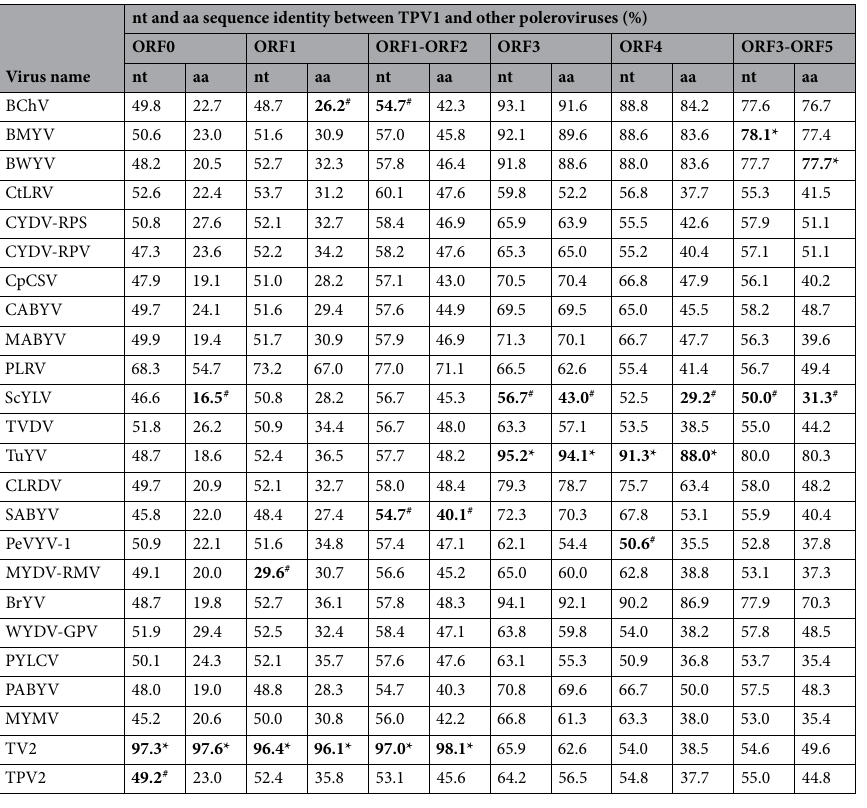
Table 3. Nucleotide and amino acid sequence comparisons of different ORFs of TPV1 with those of other poleroviruses. The bold in the table represent the highest and lowest identities individuals. nt Nucleotide, aa amino acid, *the virus shares the highest nt or aa sequence identity with TPV1; # the virus shares the lowest nt or aa sequence identitiy with